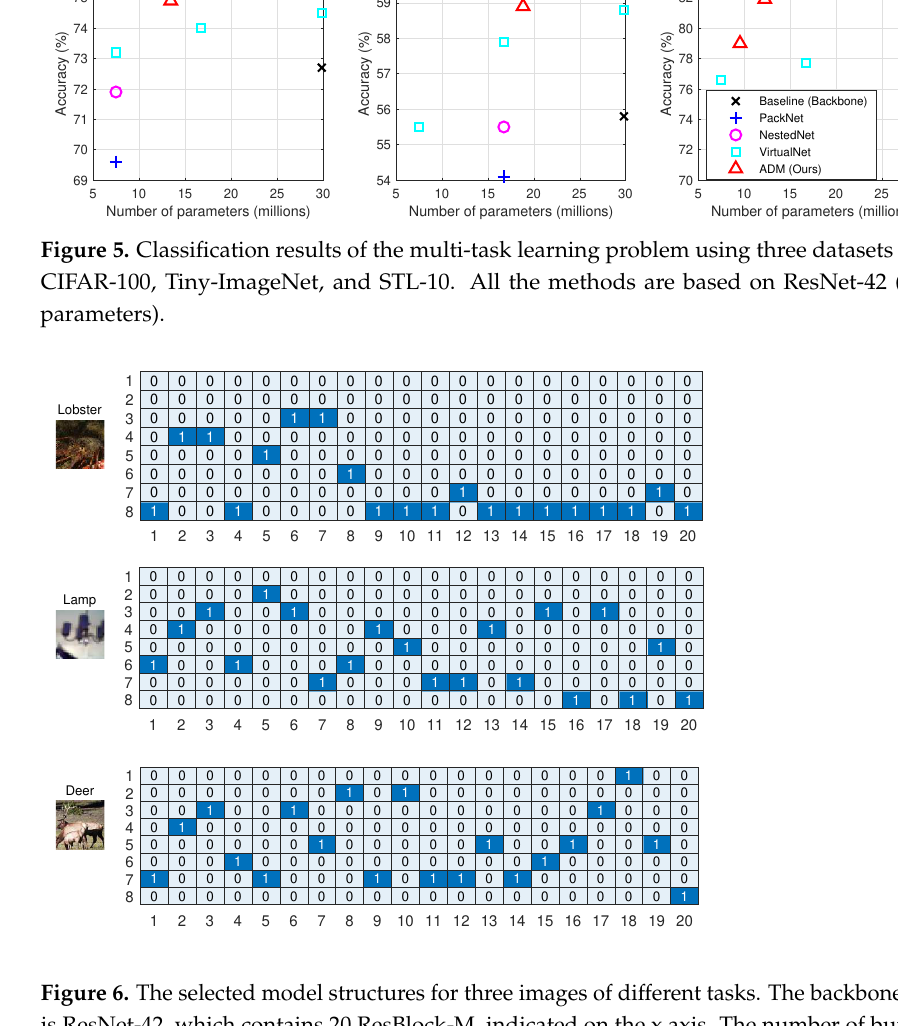
Figure 6. The selected model structures for three images of different tasks. The backbone architecture is ResNet-42, which contains 20 ResBlock-M, indicated on the x axis. The number of building blocks is three, thus we have 2 3 = 8 choices for the building blocks in each ResBlock-M (e.g., 1 indicates nothing is chosen, and 8 indicates all the building blocks are selected on the y axis). The difficulty of the images decreases from top to